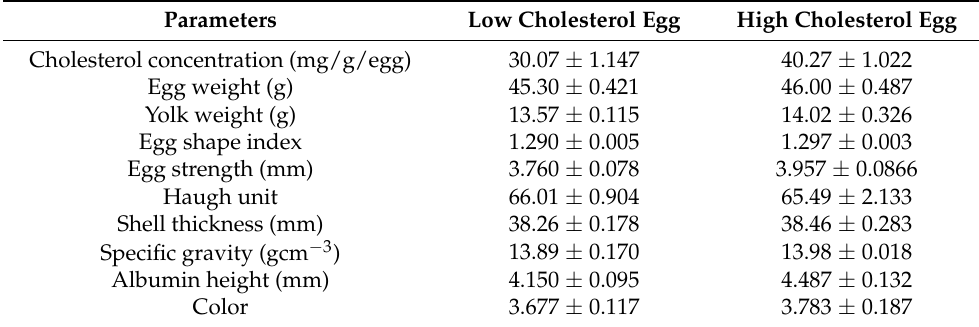
Table 2. The table showed the egg quality parameters and cholesterol amount determined in egg yolk in low and high cholesterol